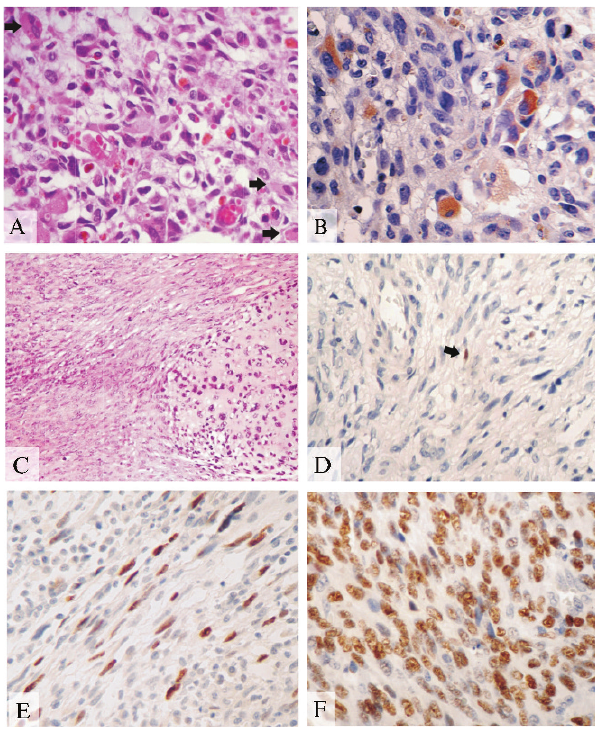
Figure 1 - Malignant triton tumor: case 4 (A and B). A. Area of differentiation in the rhabdomyosarcoma (arrows); H&E, 40x. B. Cells immunopositive for desmin; immunohistochemistry (diami- nobenzidine), 40x. C. Malignant peripheral nerve sheath tumor with heterologous differentiation in a chondrosarcoma: case 13; H&E, 20x. D. p53-immunopositive plexiform neurofibroma (arrow); immunohistochemistry (diaminobenzidine), 40x. E. Malignant peripheral nerve sheath tumor immunoreactive for p53: case 24; immunohistochemistry (diaminobenzidine), 40x. F. Malignant peripheral nerve sheath tumor immunoreactive for p53: case 4; immunohistochemistry (diaminobenzidine), 40x. OBS: positive cells in brown.